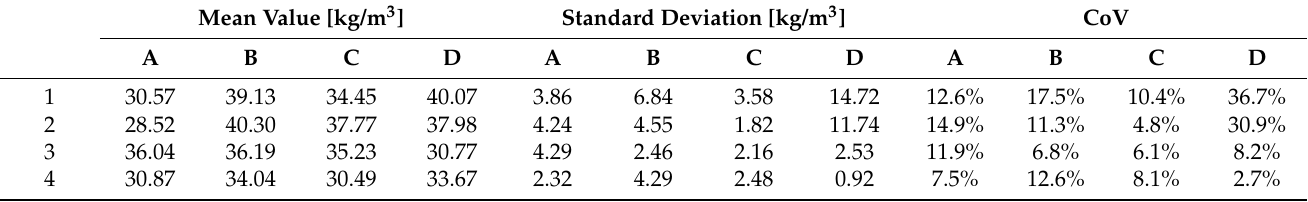
Table 6. Statistical description of the fibre quantity depending on the